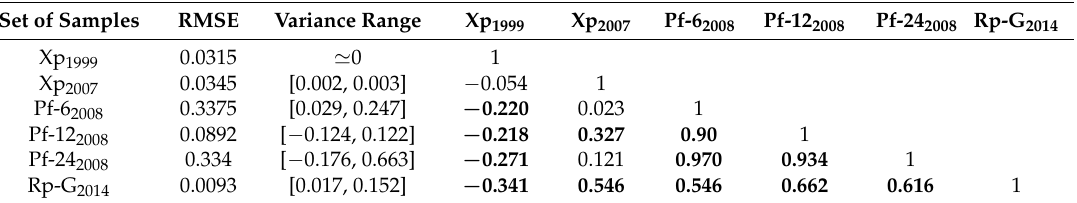
Figure 3. Result of kriging interpolation analyses based on ( a ) Xp 1999 , ( b ) Xp 2007 , ( c ) Pf-6 2008 , ( d ) Pf-12 2008 , ( e ) Pf-24 2008 , and ( f ) Rp-G 2014 samples. The notation of samples is reported in Section 2.4. Table 4. Summary of interpolation analyses carried out on Xp 1999 , Xp 2007 , Pf-6 2008 , Pf-12 2008 , Pf-24 2008 , and Rp-G 2014 datasets. RMSE and VAR are expressed in µ g g − 1 and correspond to the root mean square error and the local variability, respectively. Significant correlation values among interpolated values are reported in